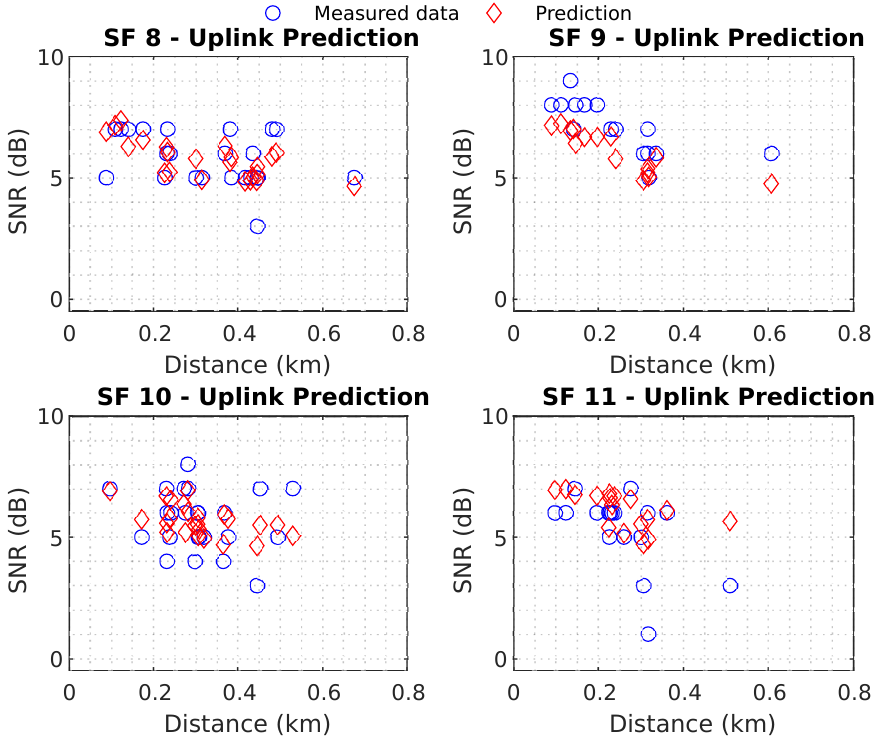
Figure 15. Uplink Best Neural Network.